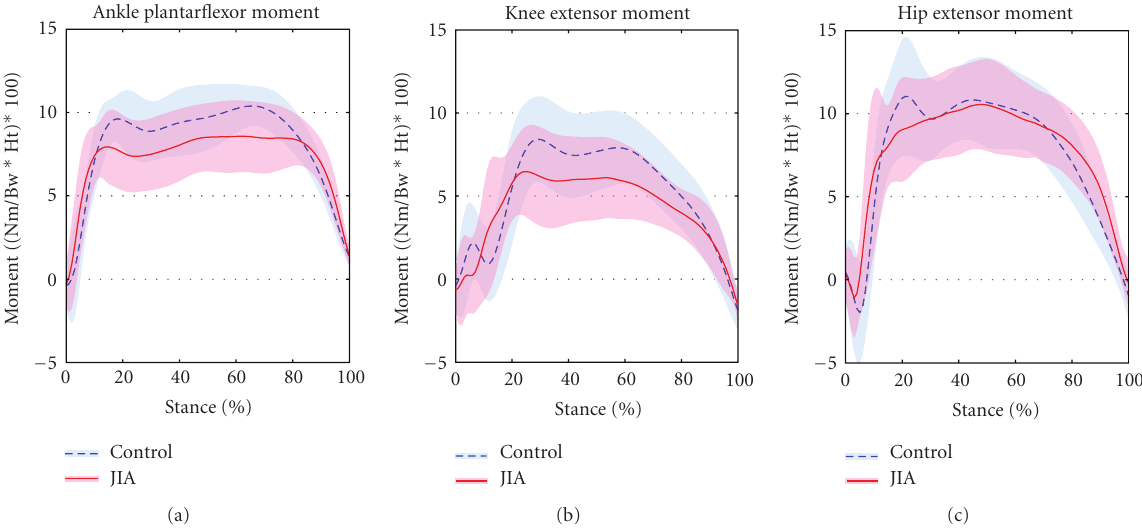
Figure 3: Ensemble averaged (mean ± 1 standard deviation) lower extremity joint moments during the drop vertical jump.